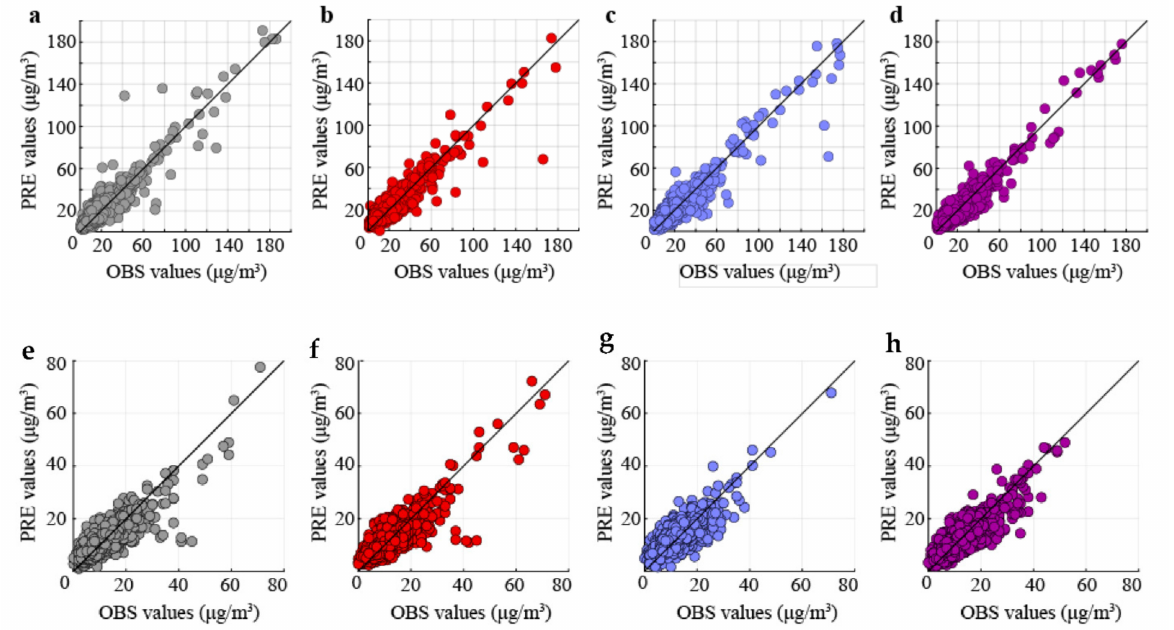
Figure 4. PM 10 and PM 2.5 scatter diagrams of the predicted versus the observed concentrations for the different input cases: ( a , e ) PM only, ( b , f ) PM and T, ( c , g ) PM and WS and ( d , h ) PM, T and WS.